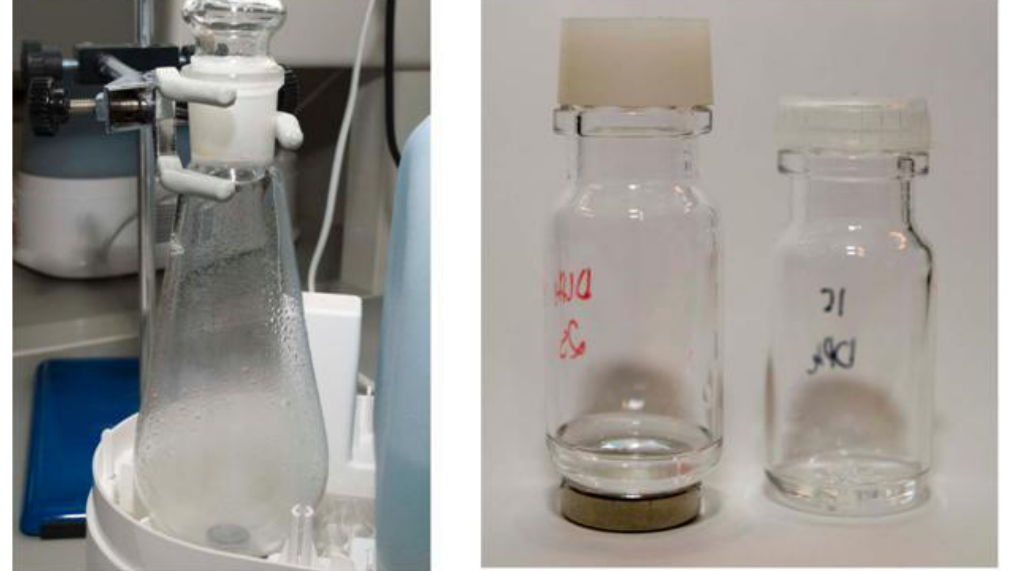
Figure 1. Water-air induced crystallization setups. ( Left ) Aerosol experimental setup. Here the flask has a magnet within the crystal vessel with the South pole facing upwards. ( Right ) Steady crystallization experimental setup, one vessel with magnetic field and one